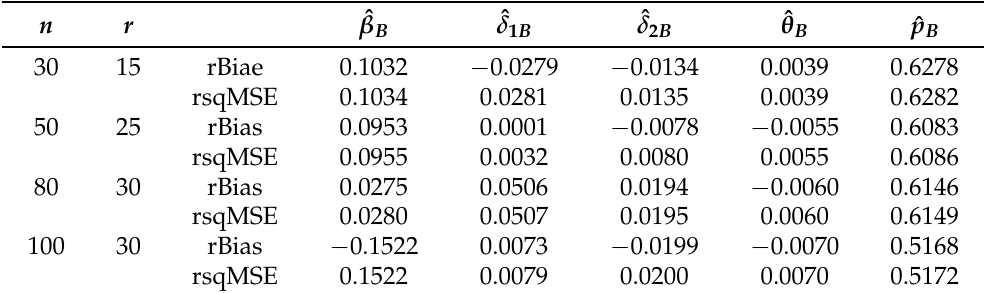
Table 3. The relative bias (rBias) and relative square root of the mean square error (rsqMSE) of Bayes estimates for p = 0.2.